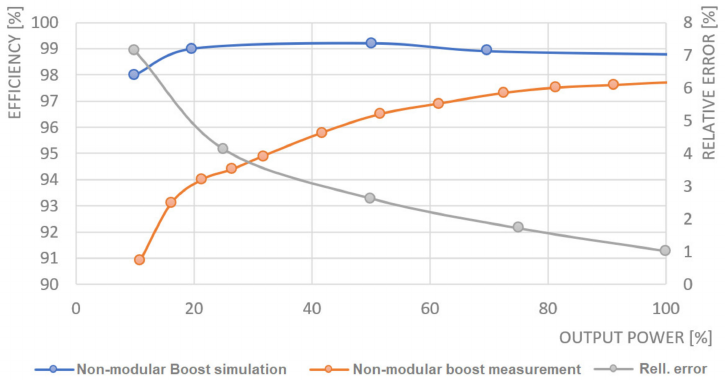
Figure 16. Comparison of efficiency characteristic for simulation (blue) and measurement (orange) results and evaluation of the relative error between results at buck mode.